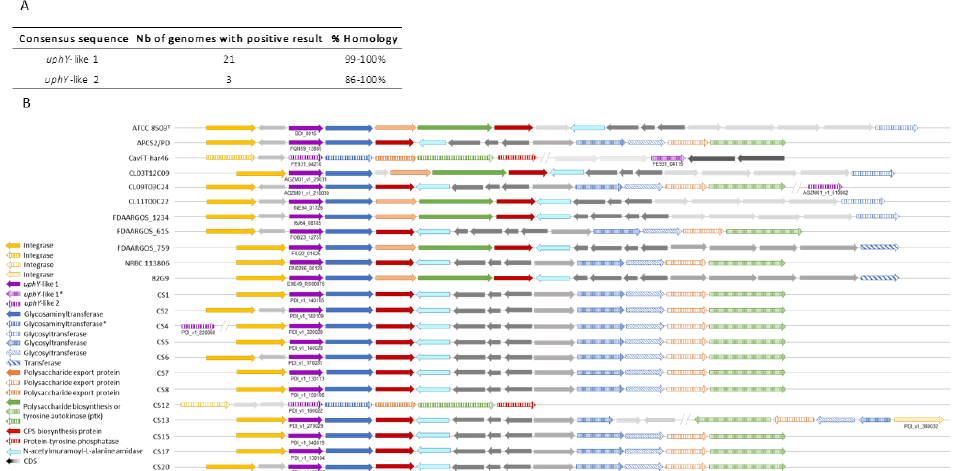
Figure 2. Identification of upxY -like gene clusters on P. distasonis genomes. ( A ) BLAST of upxY -like consensus sequences against P. distasonis genomes. ( B ) Syntenic analysis of P. distasonis capsular polysaccharide gene clusters centered on uphY -like 1 gene. Vertical and diagonal striped arrows refer to genes having a high homology and sharing synteny with reference gene. (*) indicate genes with low homology but sharing synteny over P. distasonis genomes. CDS: coding sequences are rep- resented by gray arrows. Specific research on P. distasonis ATCC 8503 T CPS loci genomes allowed us to find a 14th CPS loci, in addition to the 13 already identified [42]. All CPS loci were then explored on other P. distasonis genomes (Table 3, gene details in Table S1). Among the 26 P. dista- sonis genomes, only ATCC 8503 T and FDAARGOS_1234 possess the 14 CPS loci identified. Loci 3, 6, 9, 13 and 14 are shared between all P. distasonis , while only few strains possess loci 10, 11 and 12. Loci 7 and 8 are also conserved over genomes, but important intra- variations have been identified within these loci. Moreover, not all gene loci are different: 2 and 8 show high gene sequence conservation with a similar upxY -like gene. Locus 5 appear to be relatively close to 2 and 8 too, but with more variations. In the same way, the locus 4 shows some similarities with 2, 5 and 8 but has a different upxY . On the contrary, locus 13 possesses a similar upxY to 2, 5 and 8 but a different locus. Loci 3, 6, 7 and 1, 11, 12 also display similarities, especially between 6, 7 and 11, 12. Locus 1, although close to 11 and 12, presents a distinct upxY . Moreover, the conserved part of locus 9 does not al- ways seem to be the one involved in the CPS synthesis. In addition to upxY genes, several of these CPS loci contain a phage insertion (N- acetylmuramoyl-L-alanine amidase, homolog of phage T7 lysozyme) that may modulate its expression (Table 3). Among them, CPS loci 1 and 13 of the 26 P. distasonis genomes all harbor these insertions. For CPS loci 1, this inserted segment (light blue arrows in Figure 2) is oriented in the opposite direction to upxY -like gene downstream of the CPS biosyn- thesis genes (red arrows in Figure 2). Table 3. Identification of CPS loci in 26 P. distasonis genomes and phage insertion within clusters. Color code: presence (green), partial presence (orange) or absence (red) of the CPS locus by compar- ison with ATCC 8503 T CPS loci. Partial clusters include loci either possessing similar genes com- pared to ATCC 8503 T loci but no upxY -like gene or an identical upxY -like gene to ATCC 8503 T but a di ff erent gene locus. ● indicate loci containing phage gene insertions.